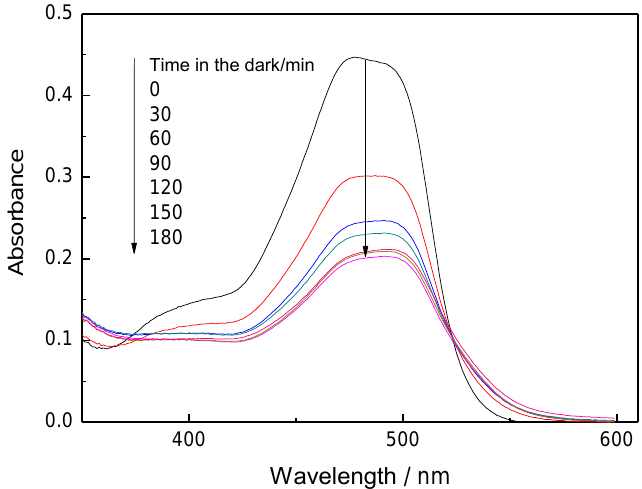
Figure 2. Absorbance of an aqueous solution containing OG and AA recorded at various contact times with the photocatalyst 3C 60 /MCM-41 in the dark.